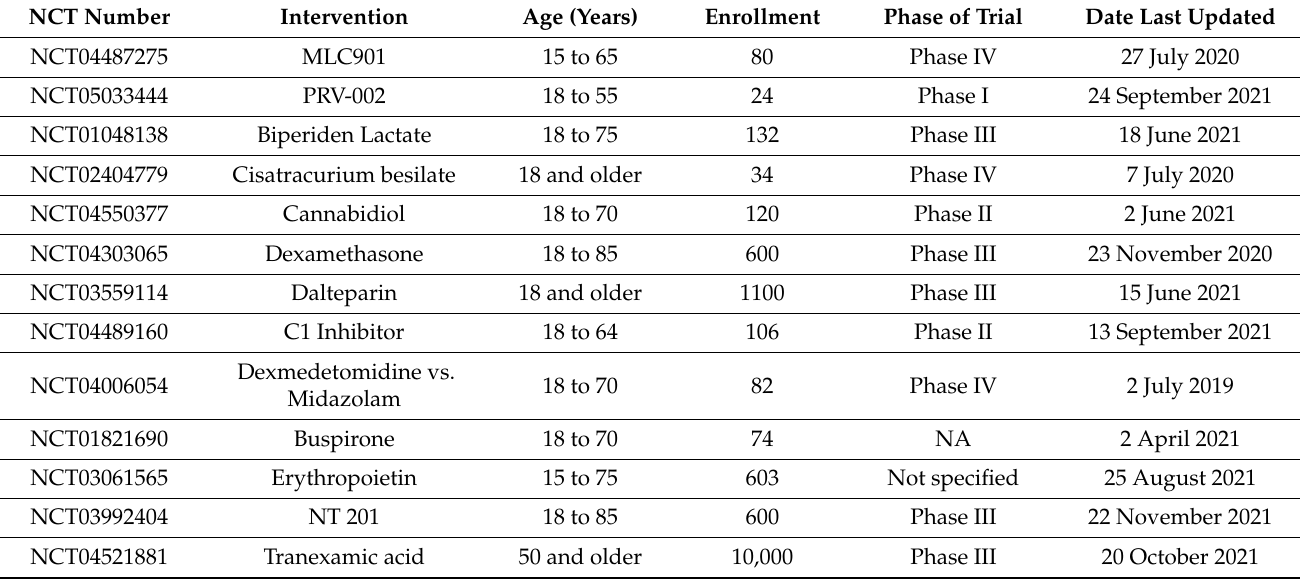
Table 3. Studies active and currently recruiting (as of 3 December